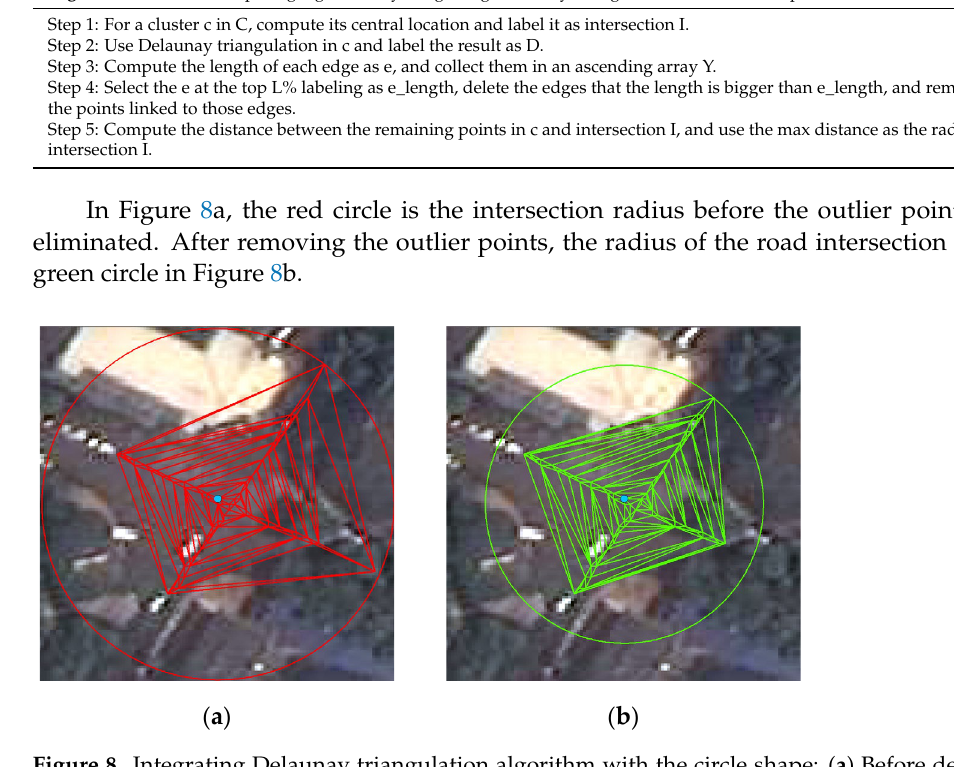
Figure 8. Integrating Delaunay triangulation algorithm with the circle shape: ( a ) Before deleting outlier points; ( b ) After deleting outlier points.